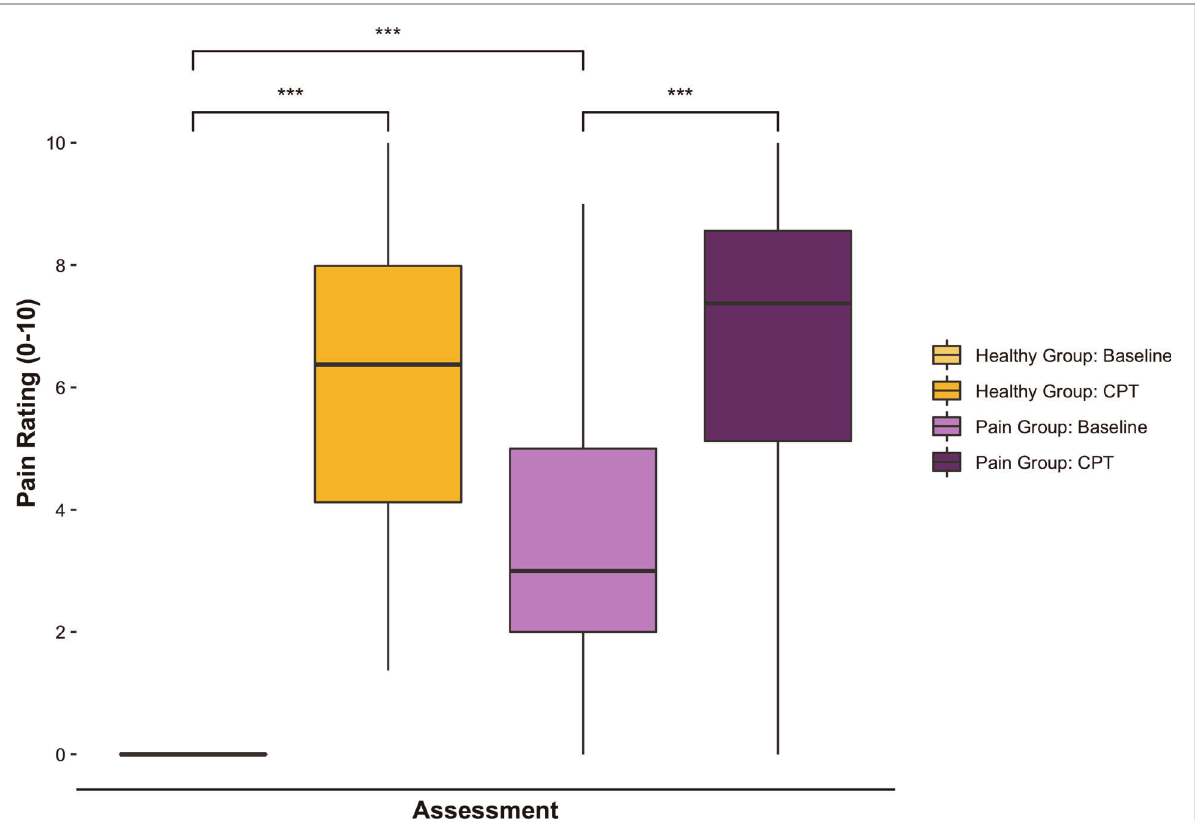
FIGURE 1 Subjective pain ratings before and after the CPT. Bar charts displaying self-reported pain scores (numeric rating scale 0 – 10) at baseline and during the CPT (average score throughout the condition). All healthy participants reported no pain (0) at baseline. Both healthy and chronic pain participants had signi fi cantly higher pain scores during the CPT compared to baseline. Chronic pain participants had signi fi cantly higher scores than healthy participants at baseline, but average pain scores throughout the CPT were not signi fi cantly different between groups. ***denotes signi fi cance at p <0.001